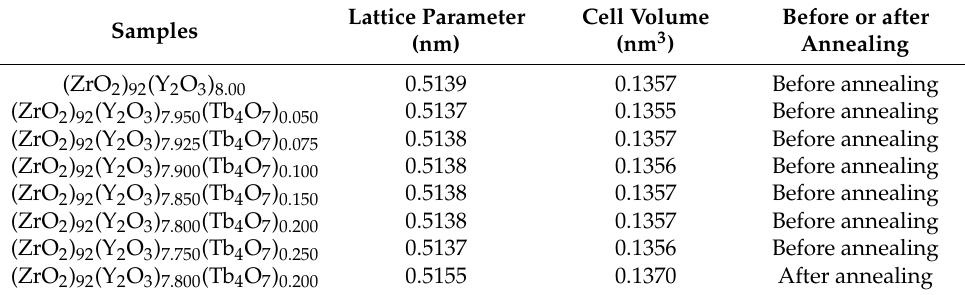
Table 2. The lattice parameter of (ZrO 2 ) 92 (Y 2 O 3 ) 8 − x (Tb 4 O 7 ) x